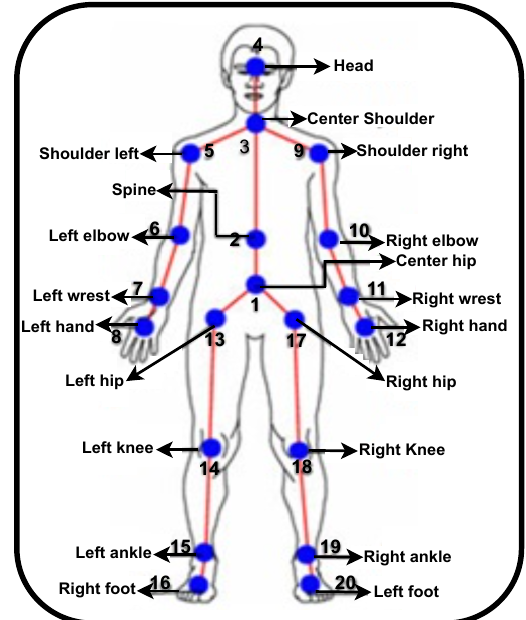
Figure 3. Various human